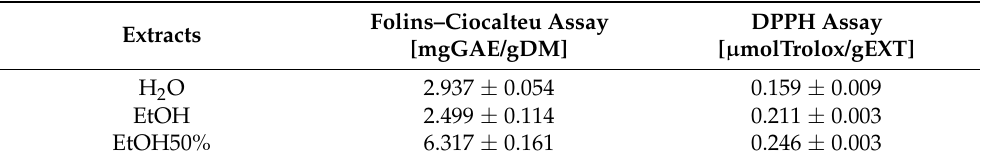
Table 1. Quantification of total phenols concentration and radical scavenging using Folin–Ciocalteu and DPPH assay,